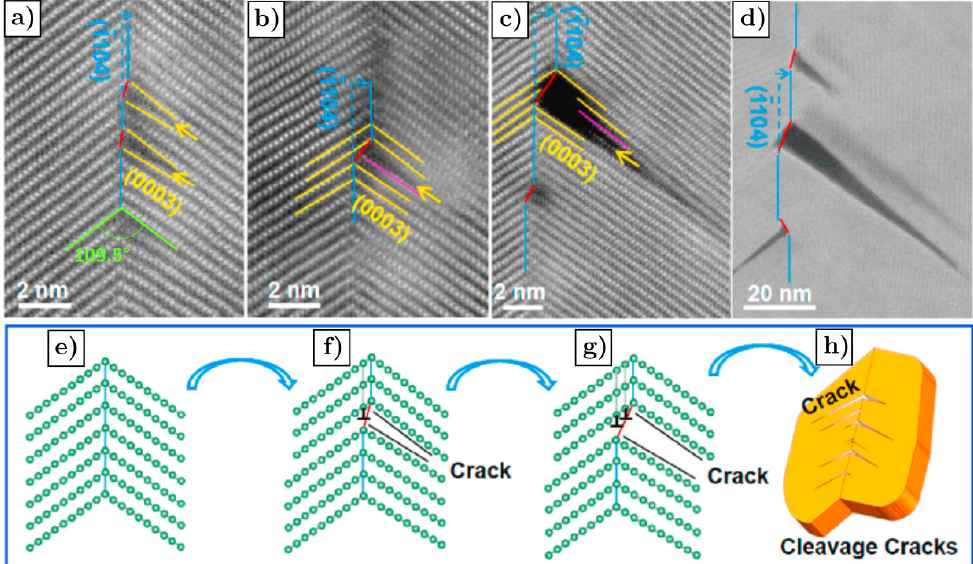
Figure 29. Cleavage crack’s nucleation and propagation. ( a ) STEM-HAADF image showing the nucleation of cleavage cracks at the kinks occurring after 50 cycles. The (0003) plane is highly strained as indicated by the yellow arrows. ( b , c ) Further deformation-induced crack growth at the twin boundary. Pink lines indicate the extra (0003) planes generated to release the local strain. ( d ) V-shaped cleavage cracks induced by deformation. ( e – h ) Schematic diagrams to illustrate the cleavage crack nucleation and growth process. Reprinted with permission by Elsevier from [136], Copyright